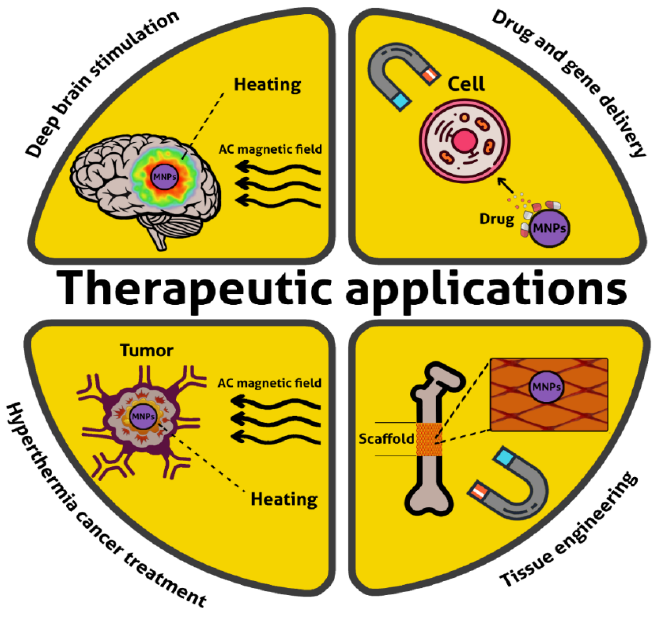
Figure 4. Therapeutic applications of MNPs. MNPs could be applied in various fields of therapy, such as drug/gene delivery, hyperthermia cancer treatment, deep-brain stimulation (DBS), and tissue engineering for regenerative medicine.